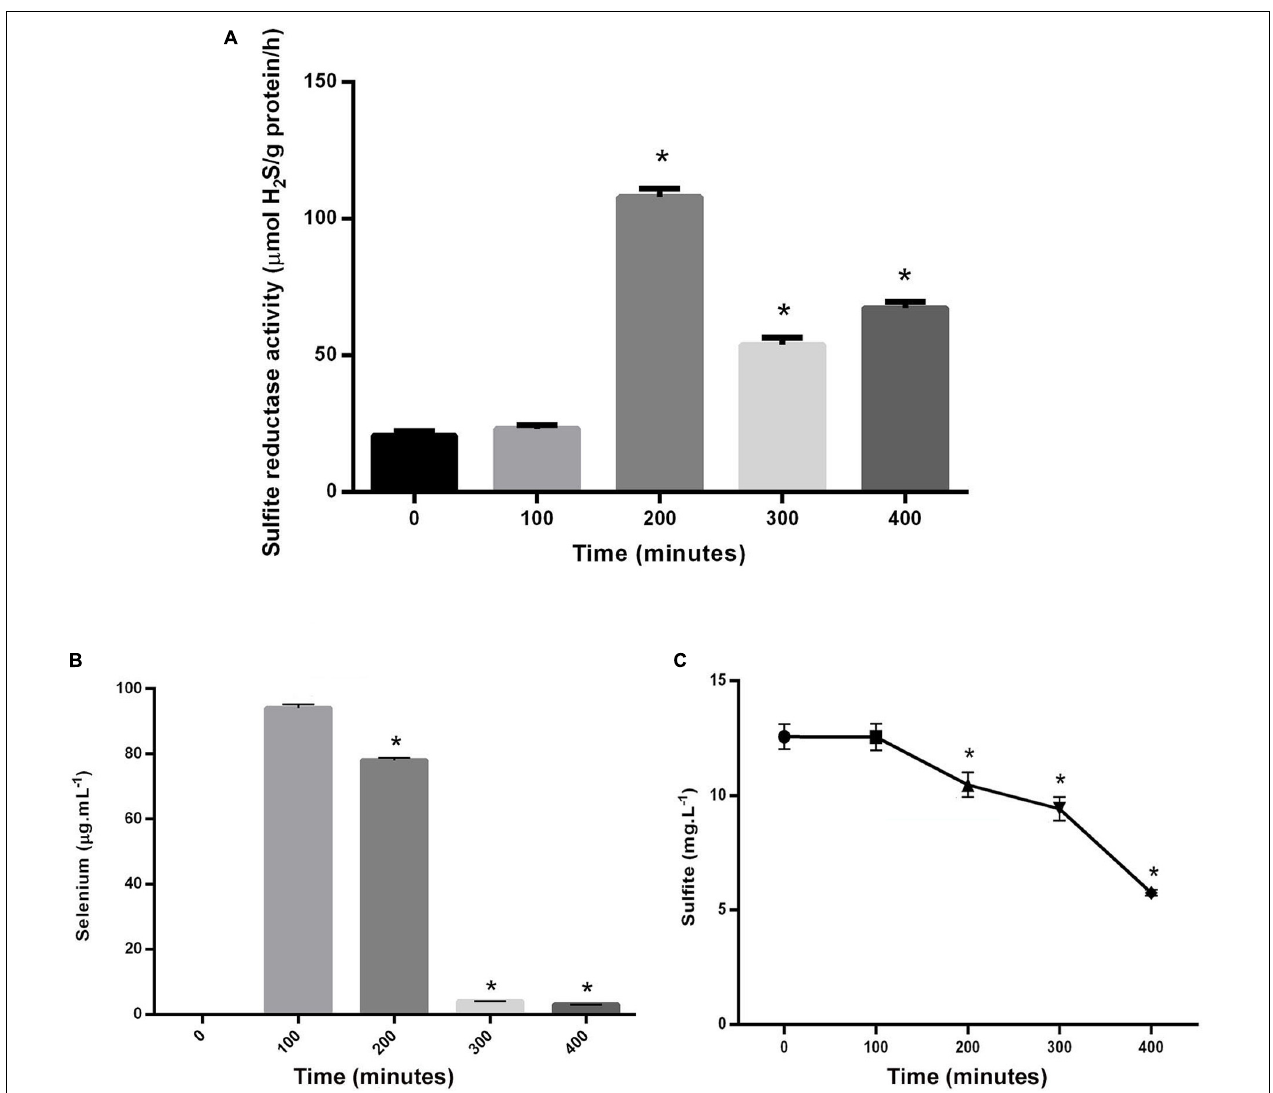
FIGURE 3 | (A) Comparison between the variation of sulfite reductase activity in S. cerevisiae in time point zero and experiments in following time points. (B) Comparison between selenium levels in the supernatant of control and experiments in following time points. (C) Comparison between sulfite levels in the supernatant of control and experiments in following time points. Asterisks represent significant differences at p < 0.05.